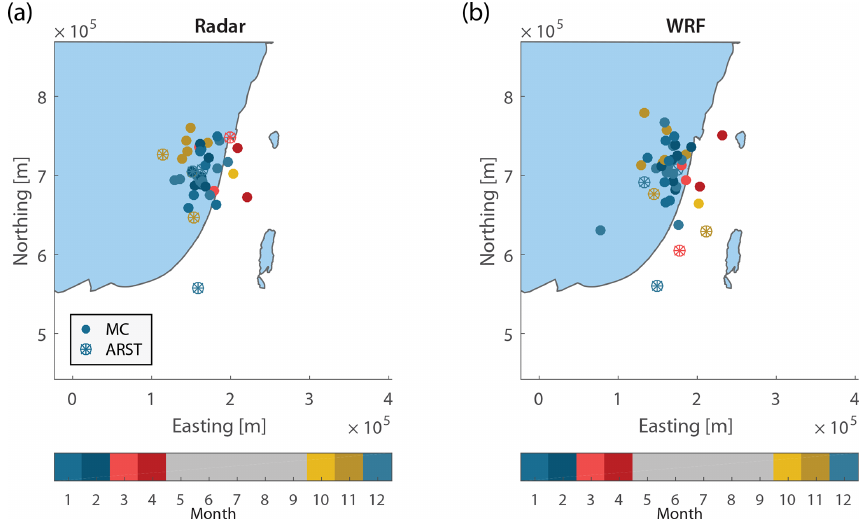
Figure 4. Centres of mass of cumulative rainfall of each of the HPEs derived from (a) the radar QPE and (b) WRF. Colours represent the month of occurrence. Synoptic classification according to Sect. 3.4.